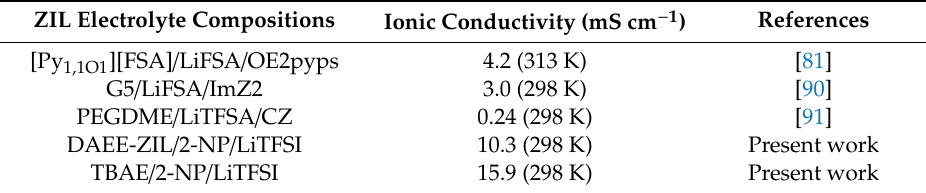
Table 10. Comparison of ionic conductivity data: Present work vs. recently published work. ZIL Electrolyte Compositions